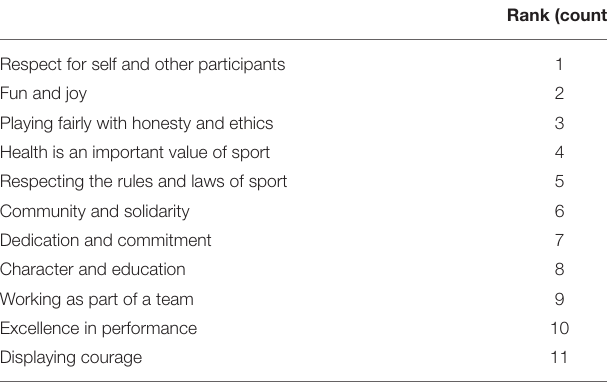
TABLE 4 | Counts analysis rankings for spirit of sport statements for entire